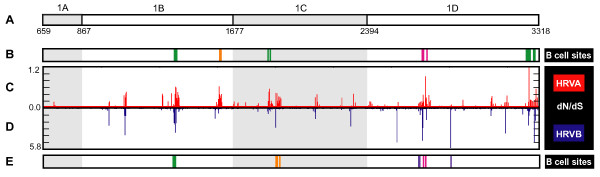
Location of selective pressure and known immunogenic sites in capsid genes. A. Zoom-in on capsid region of genome (boxed region from Figure 2), schematized as described in Figure 2. B. Location of HRVA antigenic sites A (magenta), B (green), and C (orange) based on studies of HRV2 (Appleyard et al., 1990; Hastings et al., 1990; Speller et al., 1993; Hewat and Blaas, 1996; Hewat et al., 1998). C, D. Zoom-in on dN/dS plot for capsid genes of HRVA and HRVB, respectively. E. Location of HRVB antigenic sites NimIA (magenta), NimIB (violet), NimII (green) and NimIII (orange) based on studies of HRV14 (Sherry and Rueckert, 1985; Sherry et al., 1986).